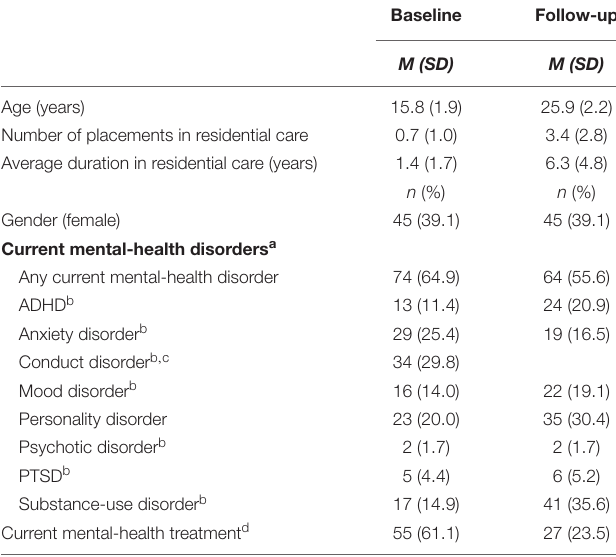
TABLE 1 | Sample characteristics at baseline and follow-up ( N =